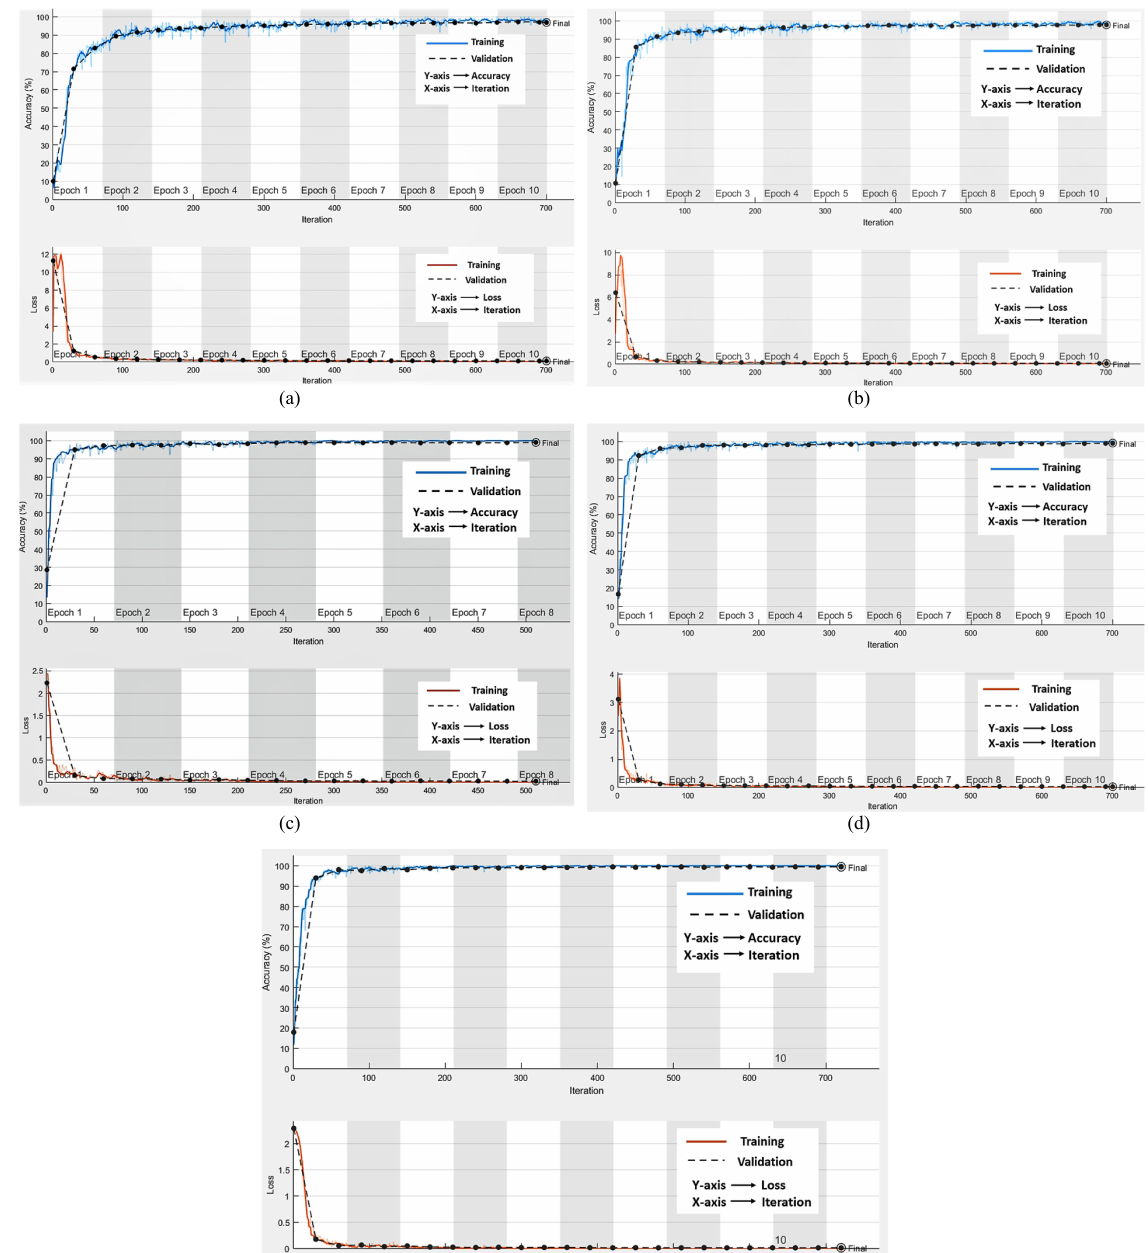
Fig. 6 Accuracy and loss graph of training progress in case of MNIST dataset: (a) Architecture 1 (b) Architecture 2 (c) Architecture 3 (d) Architecture 4 (e) Architecture 5 C.